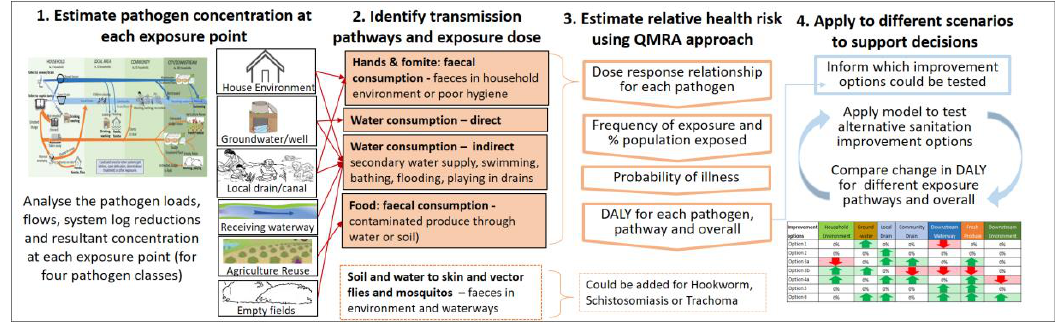
Figure 1. Conceptual approach to compare health risks of urban sanitation improvement options.